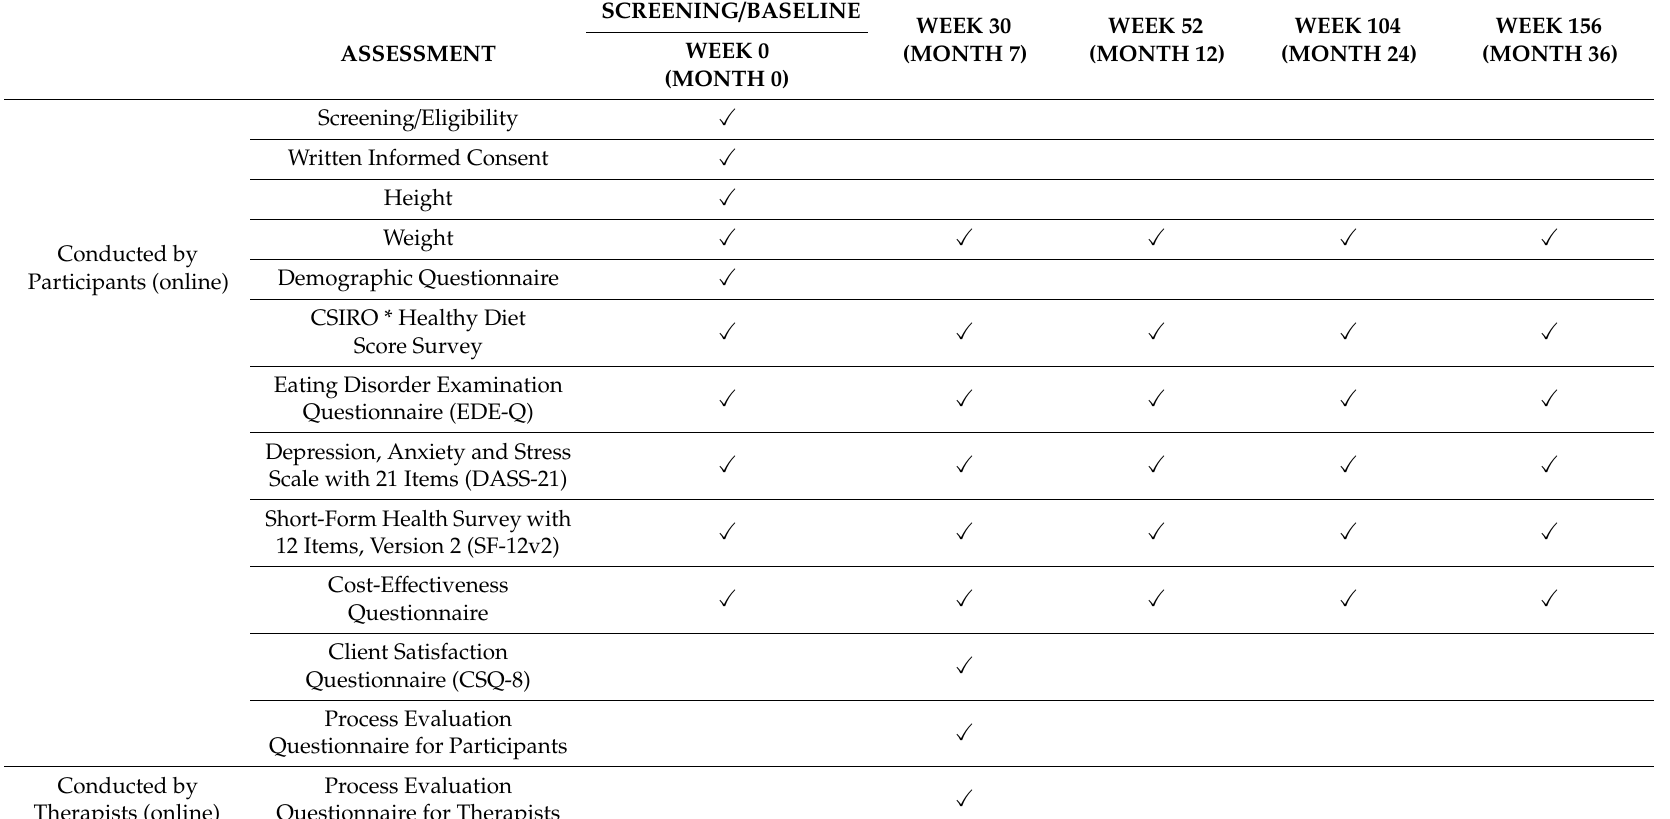
Table 1. Schedule of